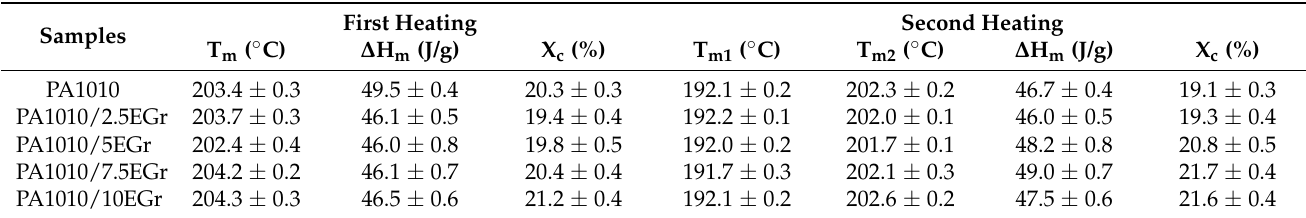
Table 3. Thermal parameters of the composites with different amounts of expandable graphite in terms of: melting temperature (T m ), normalized melting enthalpy ( Δ H m ) and degree of crystallinity